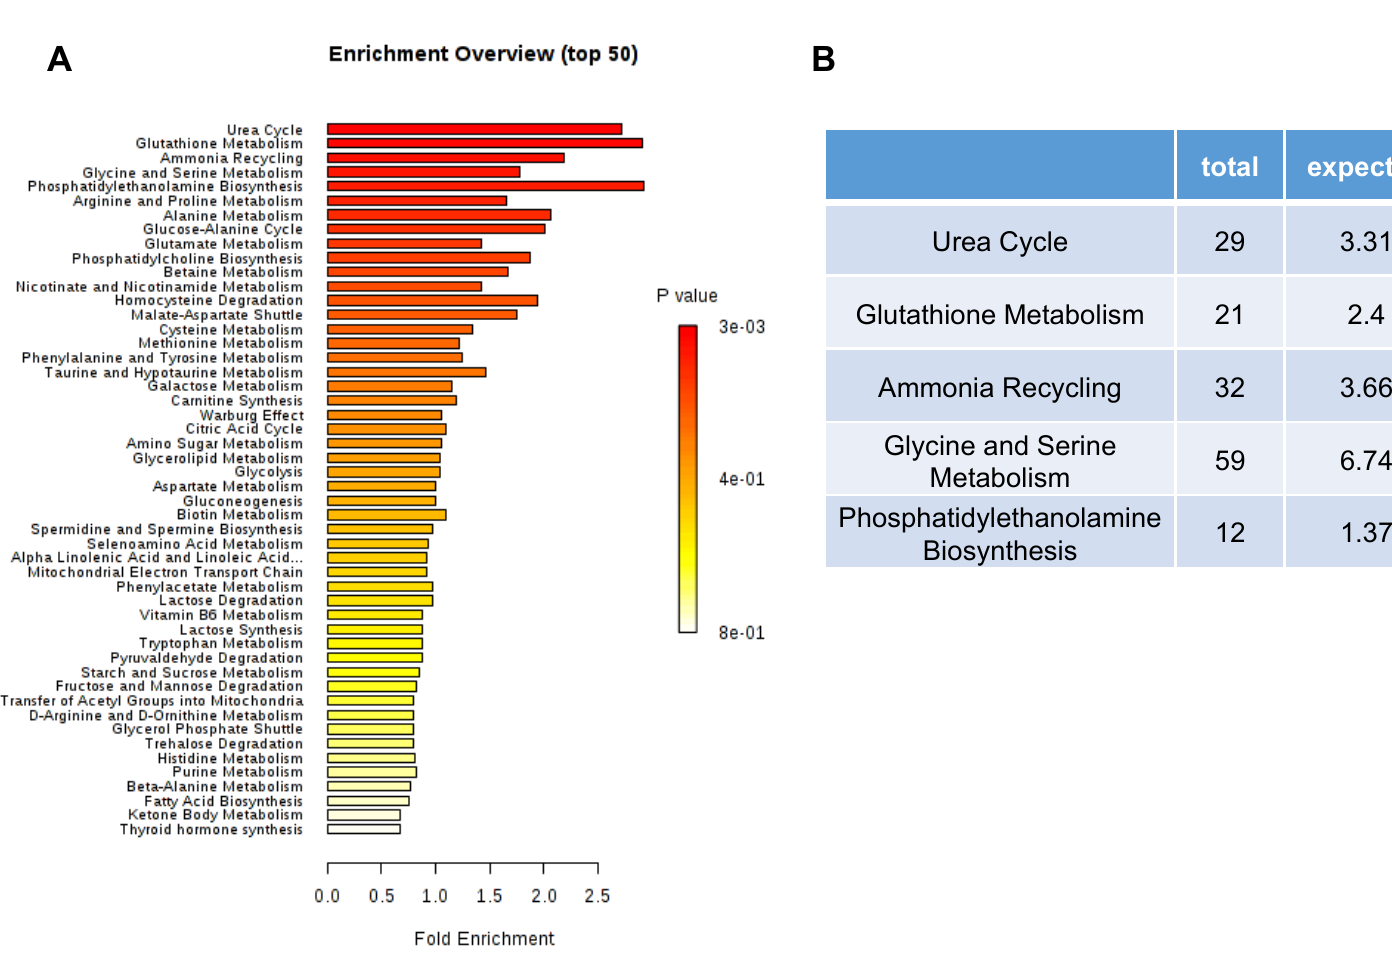
Figure 6. ( A ) Summary plot for over representation analysis (ORA) on metabolites with Mann–Whitney U test raw p -values less than 0.05. Top 50 metabolic pathway-associated metabolite sets are shown. ( B ) Five significant metabolic pathways with p -values less than 0.05.